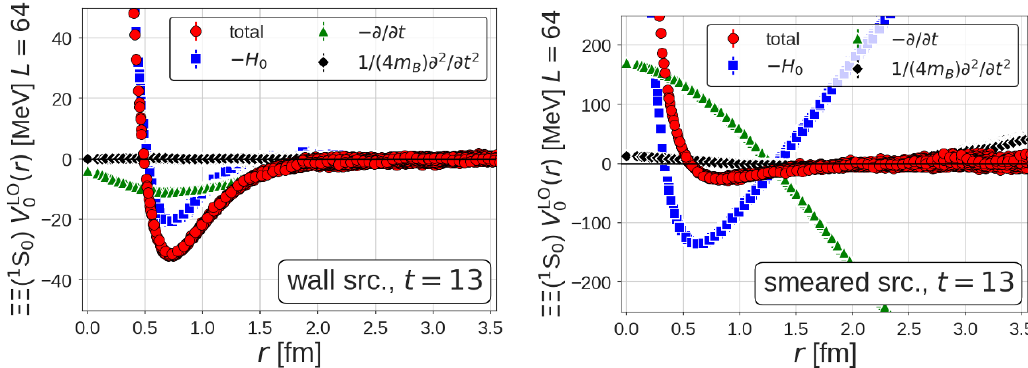
Figure 3 . The potential at the leading order (LO) analysis V LO (left) and the smeared source (right) for (cid:4)(cid:4)( 1 S 0 ) at t=a = 13 for L = 64 [20]. The blue squares, green triangles and black diamonds denote 1st, 2nd and 3rd terms in eq. (2.11), respectively.